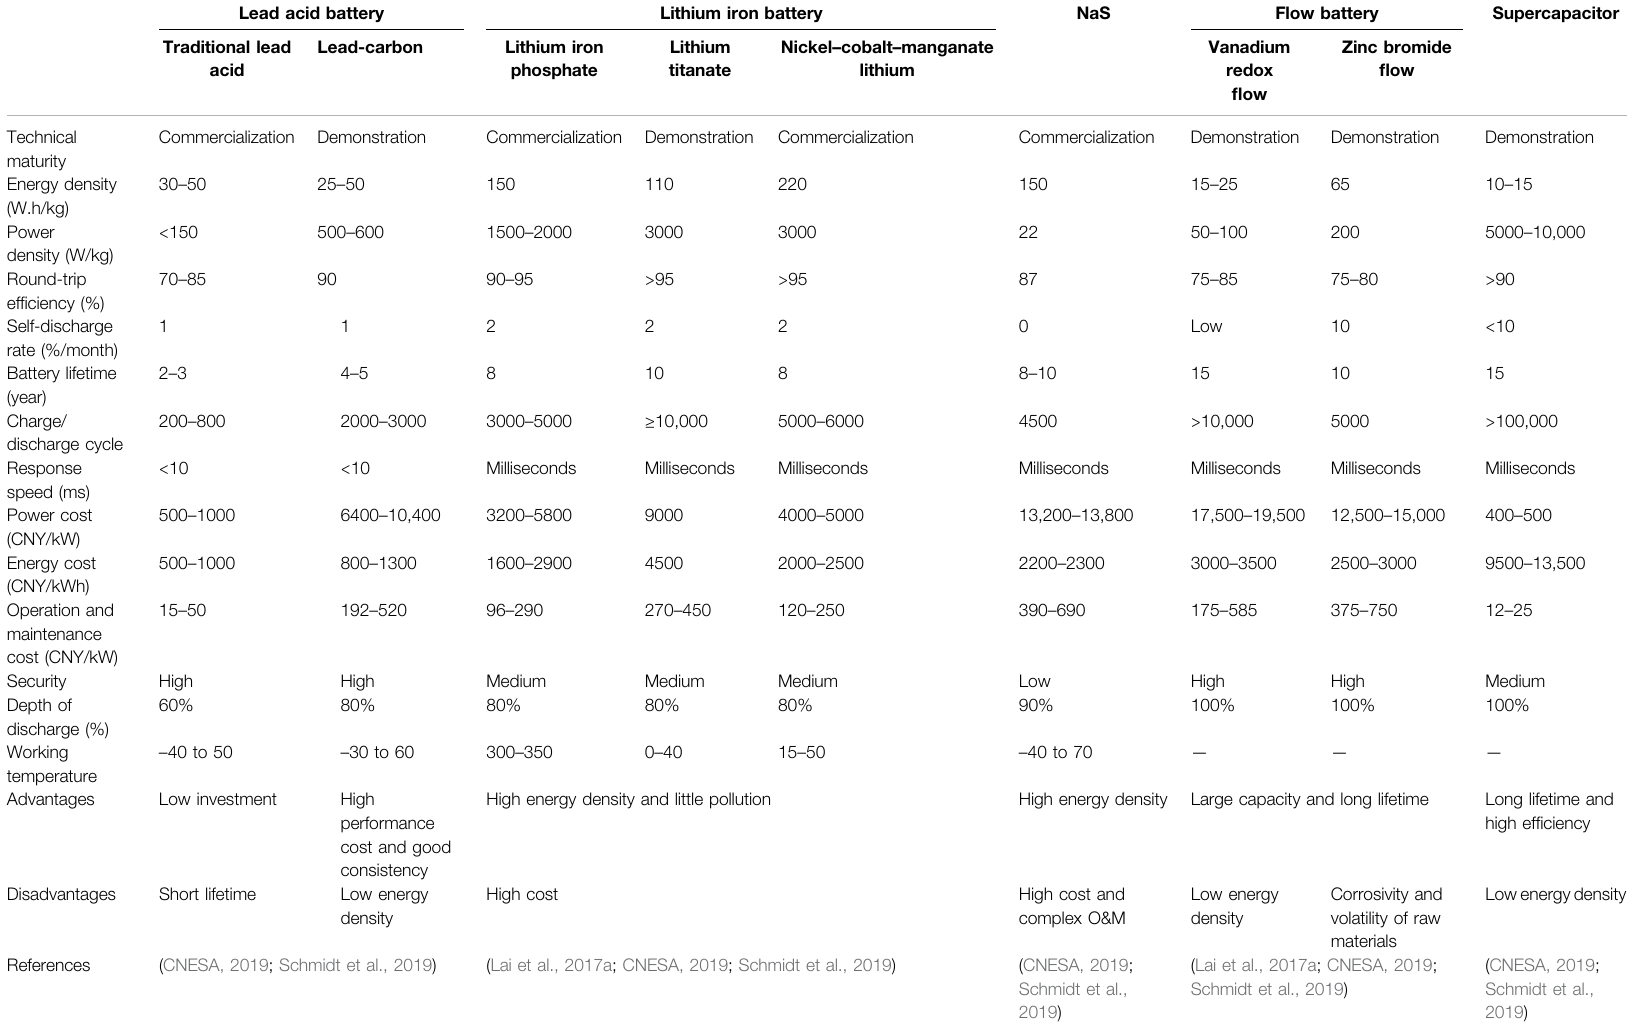
TABLE 2 | Characteristics of the EES technology in